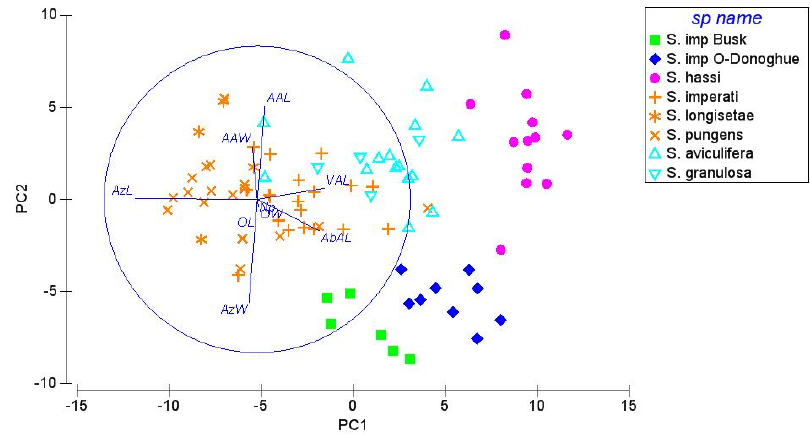
Fig. 3. Principal component analysis (PCA) biplot based on metric characters of the species Schizoretepora aviculifera (Canu & Bassler, 1930), S. granulosa (Canu & Bassler, 1930), S. hassi Harmelin, Bitar & Zibrowius, 2007, S. imperati (Busk, 1884), S. imperati sensu O’Donoghue & de Watteville 1939, S. imperati of other authors, S. longisetae (Canu & Bassler, 1928) and S. pungens (Canu & Bassler, 1925)